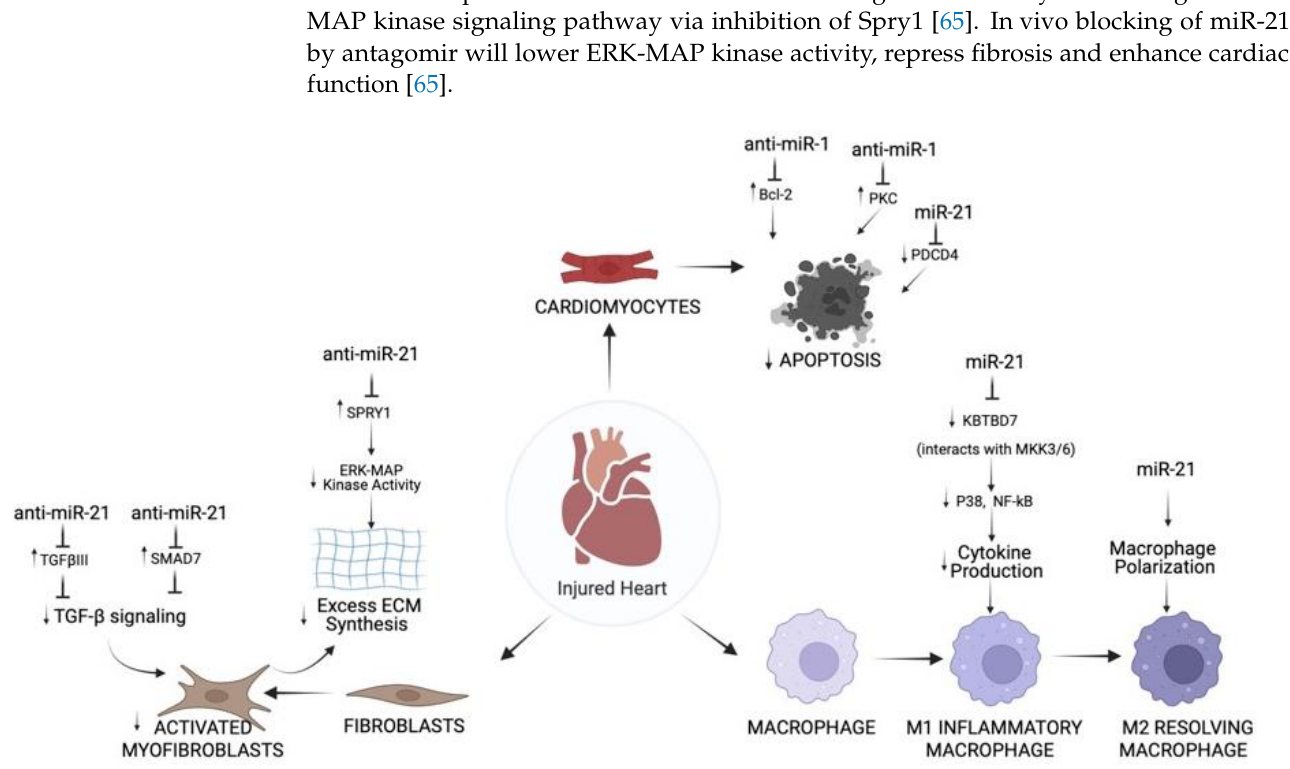
Figure 2. Overview of Action of miR-1 and miR-21 on Cardiomyocytes, Fibroblasts, and Immune Cells in Hearts Subjected to I/R Injury. In cardiomyocytes, inhibition of miR-1 prevents apoptosis via Bcl-2 and PKC, whereas miR-21 inhibits apoptosis via PDCD4. In cardiac fibroblasts, inhibition of miR-21 prevents TGF- β signaling and ECM synthesis via SMAD7, TGF β III, or SPRY1. In immune cells, miR-21 regulates multiple aspects of macrophage function, including inhibition of cytokine production and activation of macrophage polarization through P38, NF-kB. Created with BioRen- der.com.